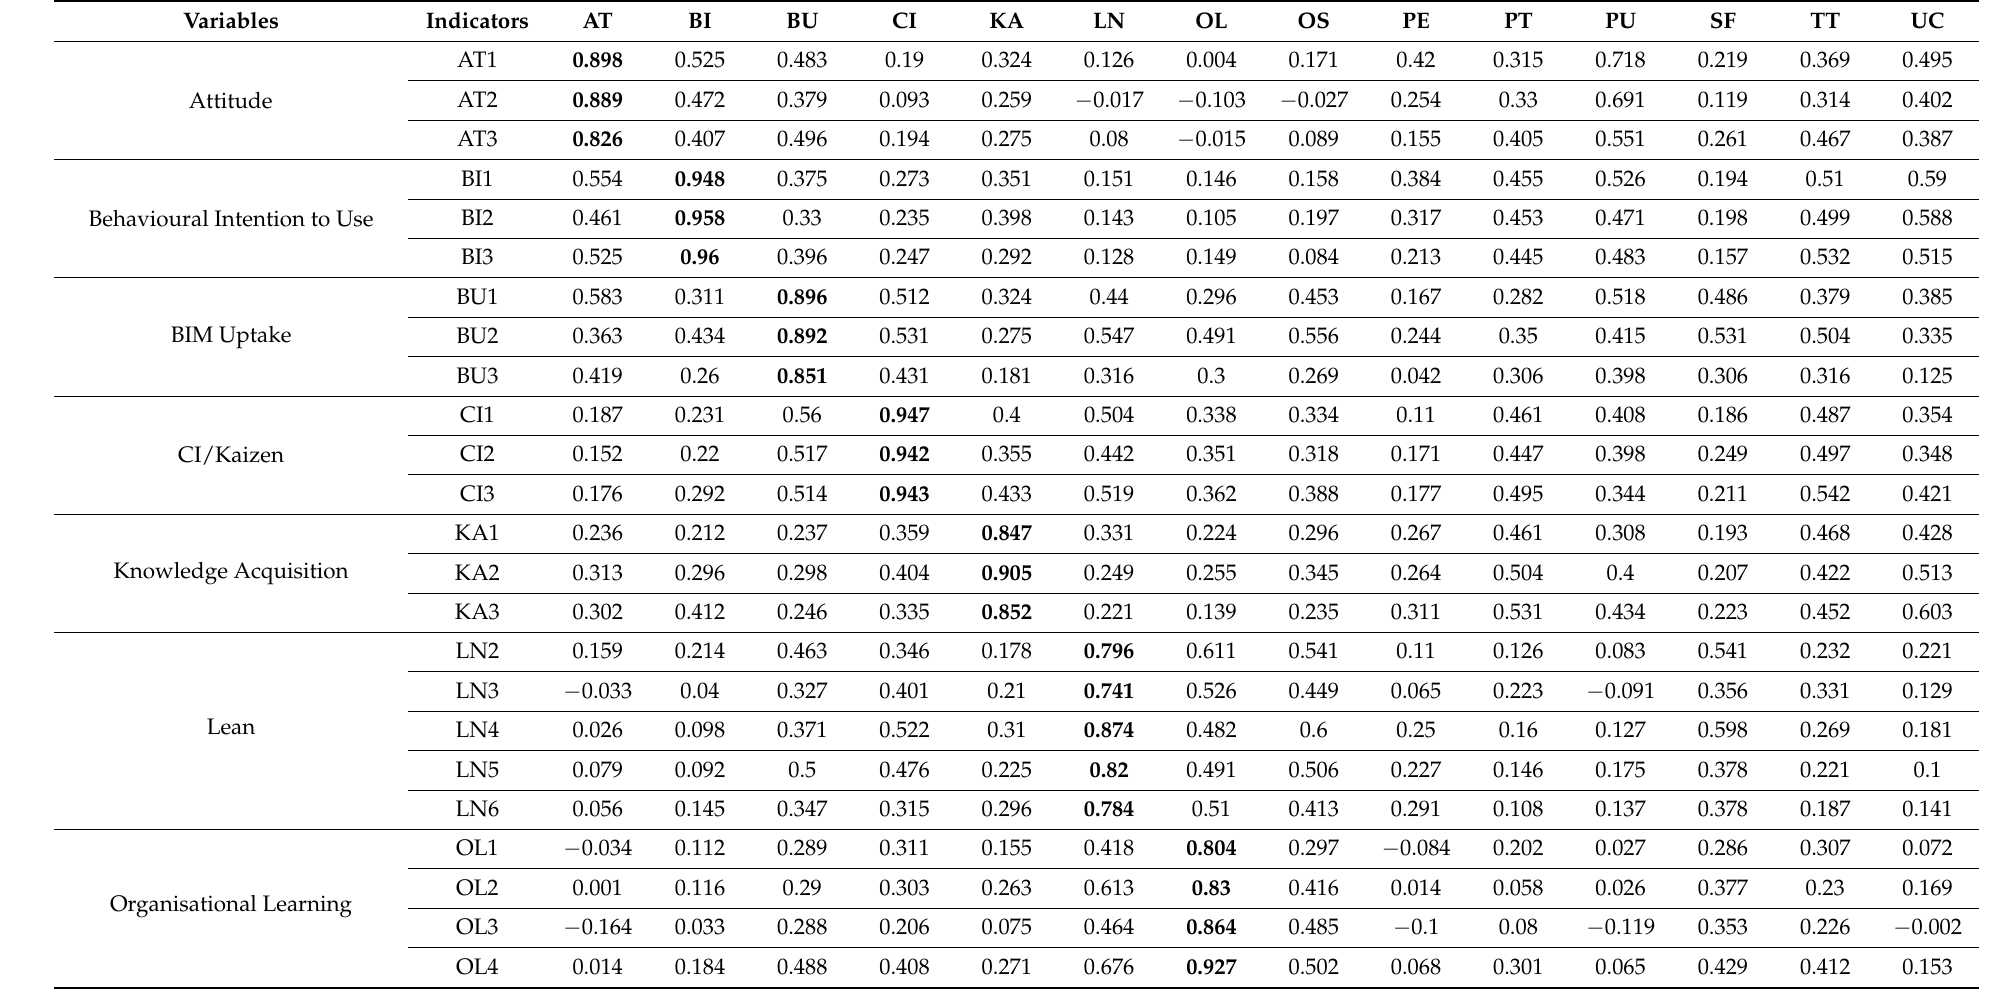
Table 4. Cross loadings